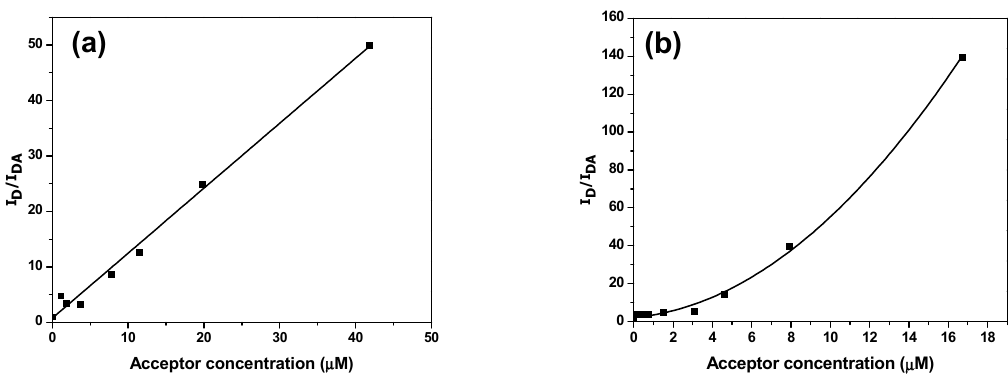
Figure 10. Stern–Volmer plots for emission quenching of PFO by various weight ratios of ( a ) MEH-PPV and ( b ) MDMO- PPV–DMP. Solid curves refer to the fitting data.